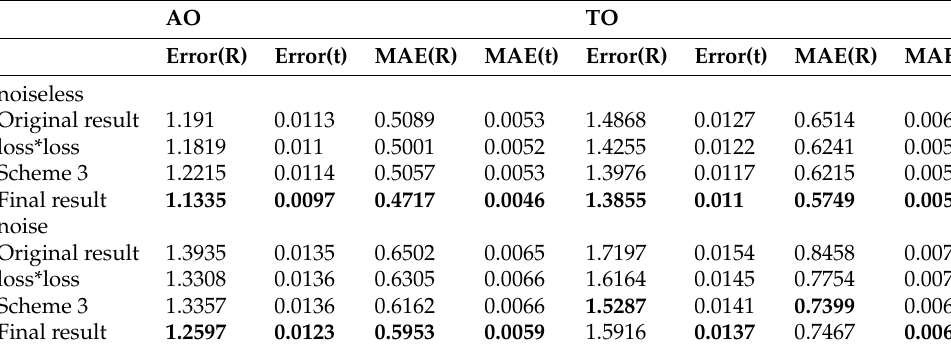
Figure 10. Comparison of different schemes: ( a ) Scheme 1 concat[x0, x1, x2, x3, x4, x5, x6, x7]; ( b ) Scheme 2 concat[x1, x3, x5, x7]; ( c ) Scheme 3 concat[x0, x3, x4, x7]. Table 4. Overall improved results on